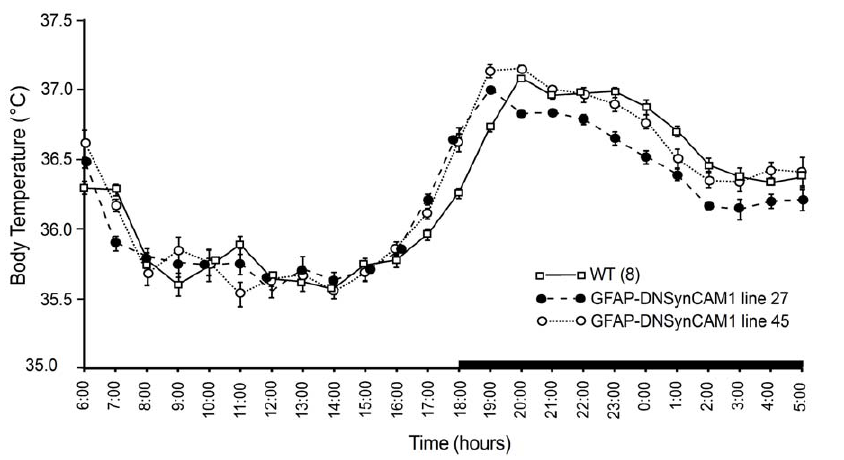
Figure 2. Average 24-hour body temperature profiles. F1 adult male GFAP-DNSynCAM1 L27 (n=8), L45 (n=6) mice and WT littermates (n=8) of an FvB/N 6 C57BL/6 J background were housed individually and 24-hour body temperature was recorded in 6-minute weighted time-averaged bins for a period of one week using MiniMitter telemetry devices. The mutant mice have a 1-hour phase shift relative to WT littermates in the peak of body temperature increase that occurs as the animals enter the dark phase.